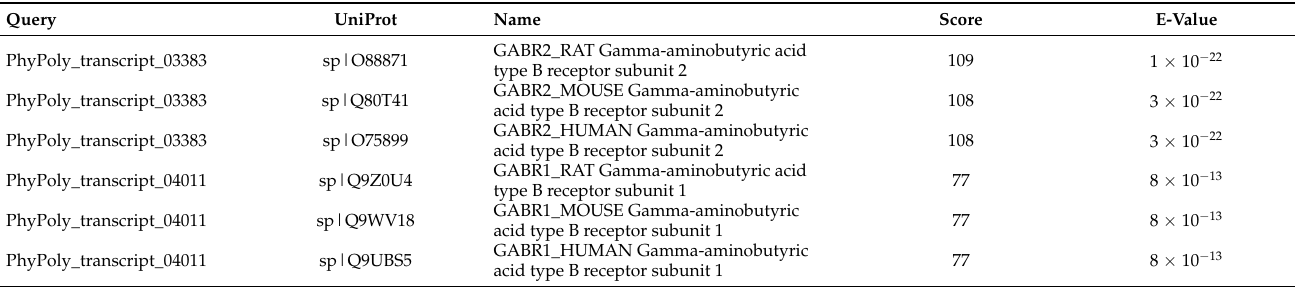
Table 1. Comparison of GABA receptor transcripts.